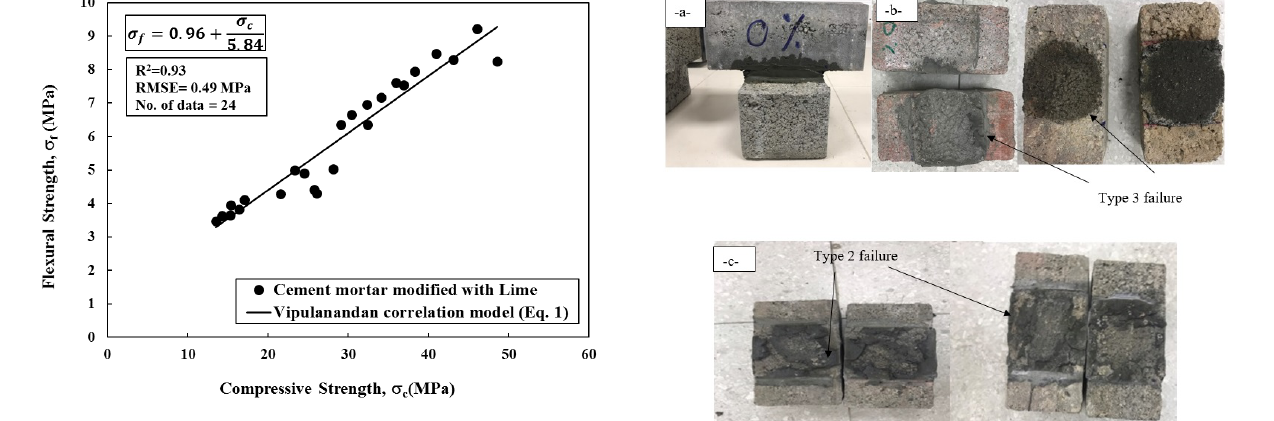
Figure 13: Relationship between compressive and flexural strength of cement mortar modified with lime of failure between the mortar and concrete bricks were type 2 failure based on CIGMAT CT-3 standard [29, 31] as shown in Fig. 15.